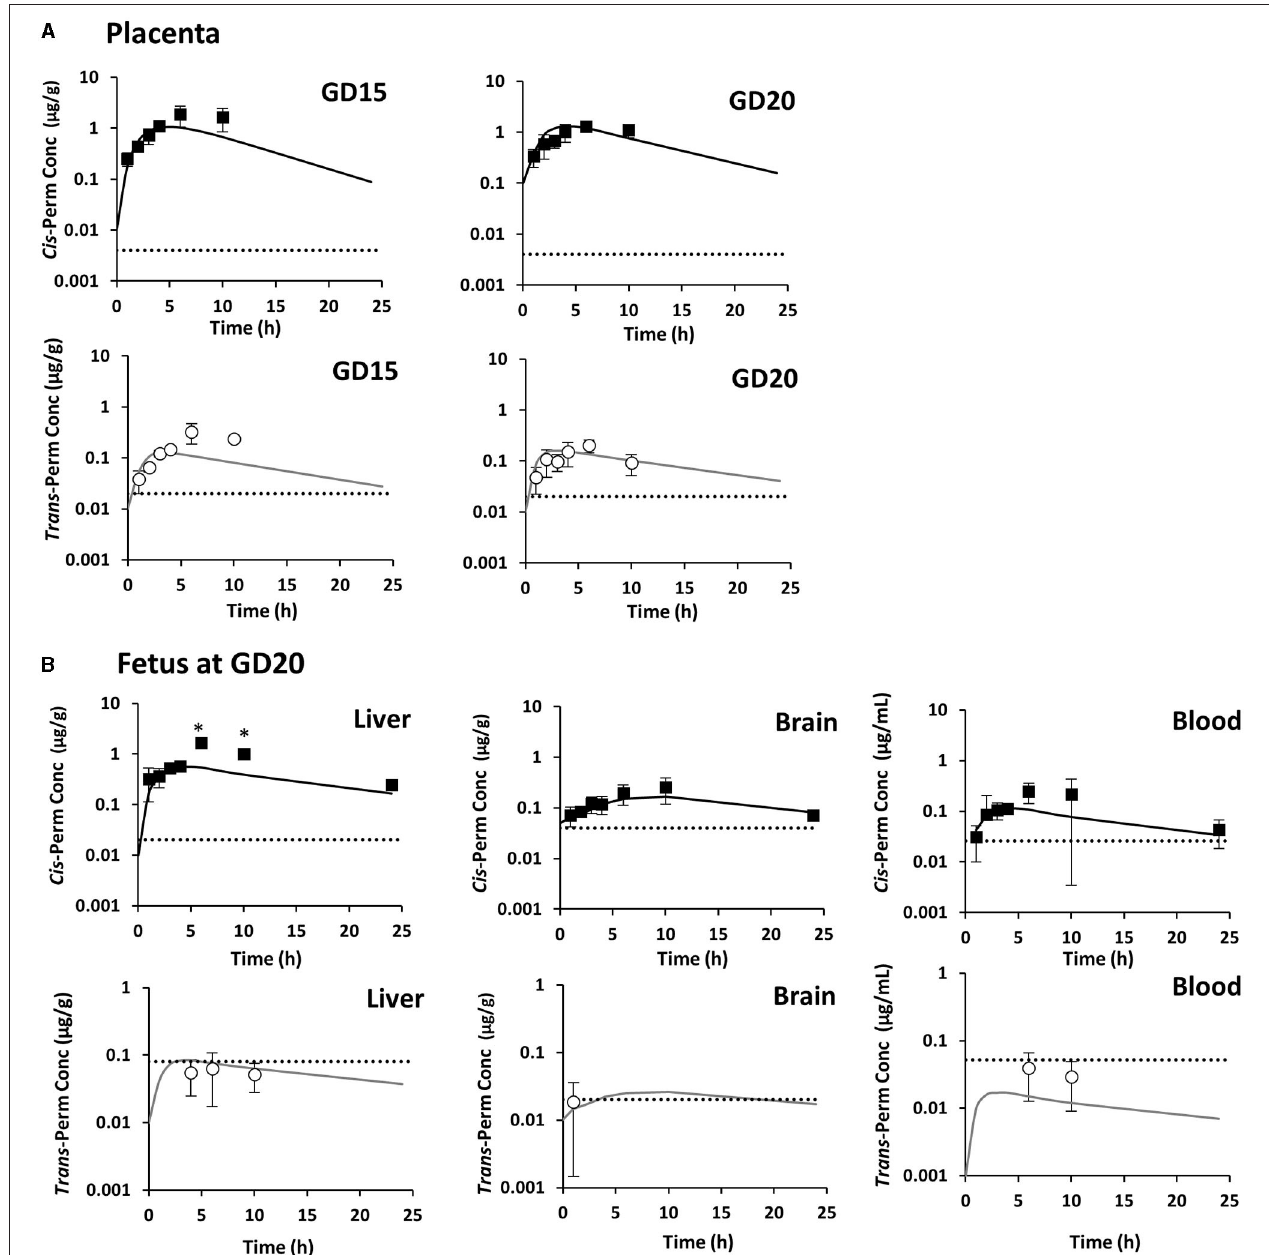
FIGURE 4 | Measured concentrations of cis- permethrin (squares) and trans- permethrin (dots) and toxicokinetic profiles estimated with the physiologically based pharmacokinetic model (solid lines) in the placenta (A) and fetal tissues (B) . Mean values ± SD for n = 4 at each time point except for the point marked with an asterisk ( n = 1). The gray dotted line stands for the limit of